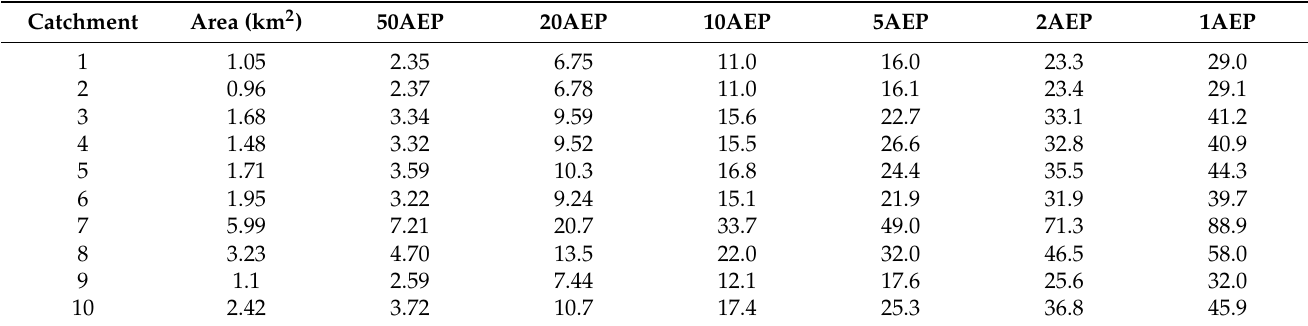
Table 3. ARR rainfall depths (mm) for a 12 h storm per AEP (%).